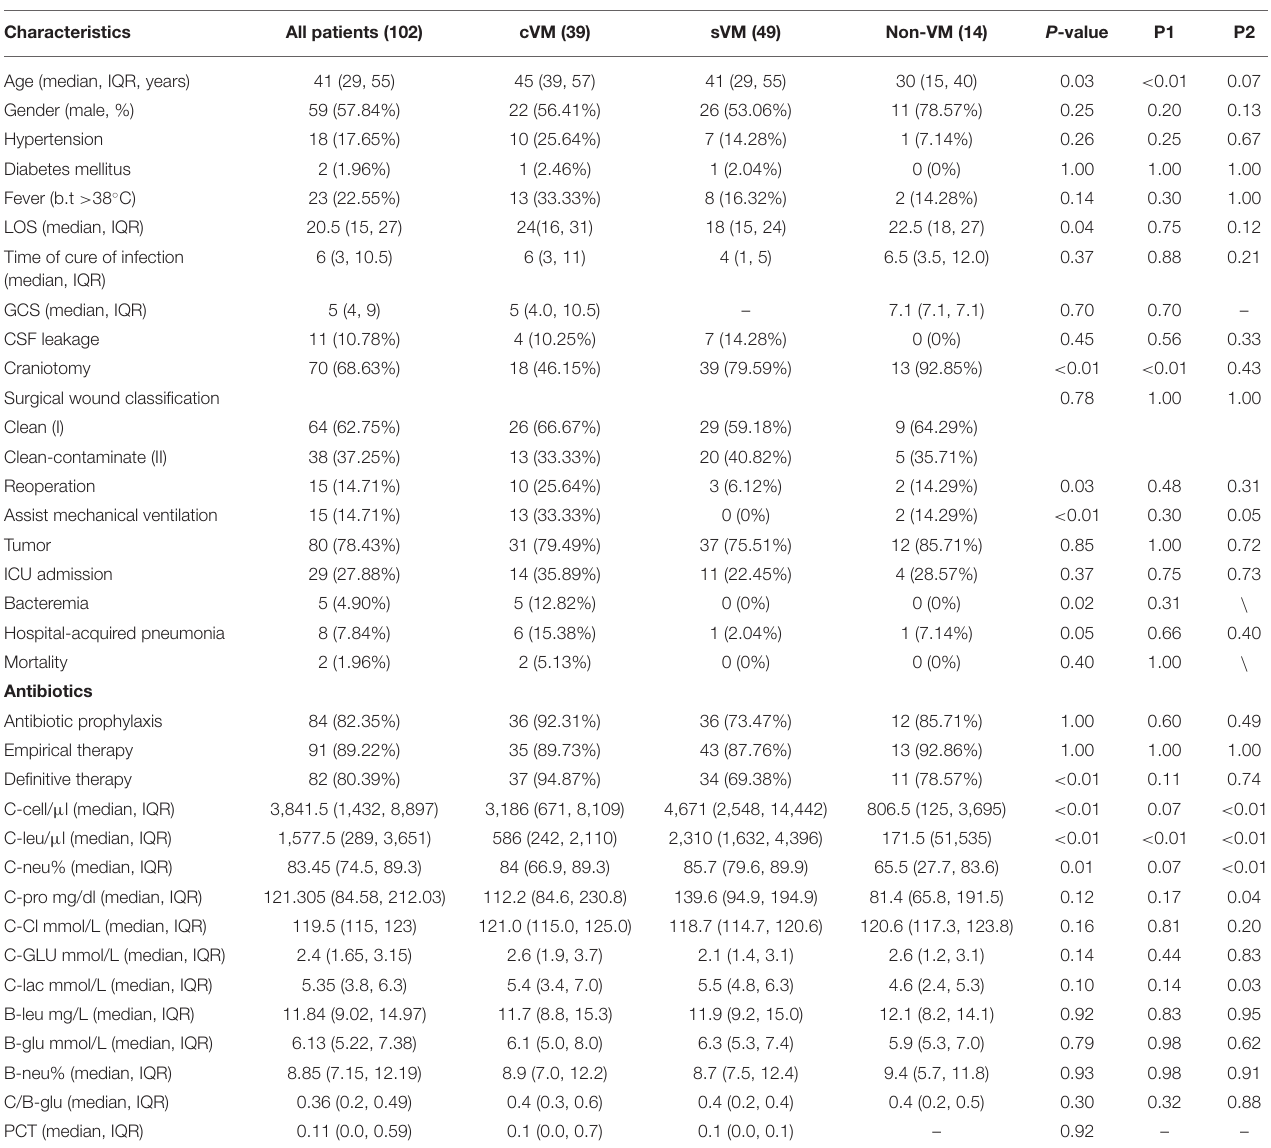
TABLE 1 | Demographic and clinical characteristics of the 102